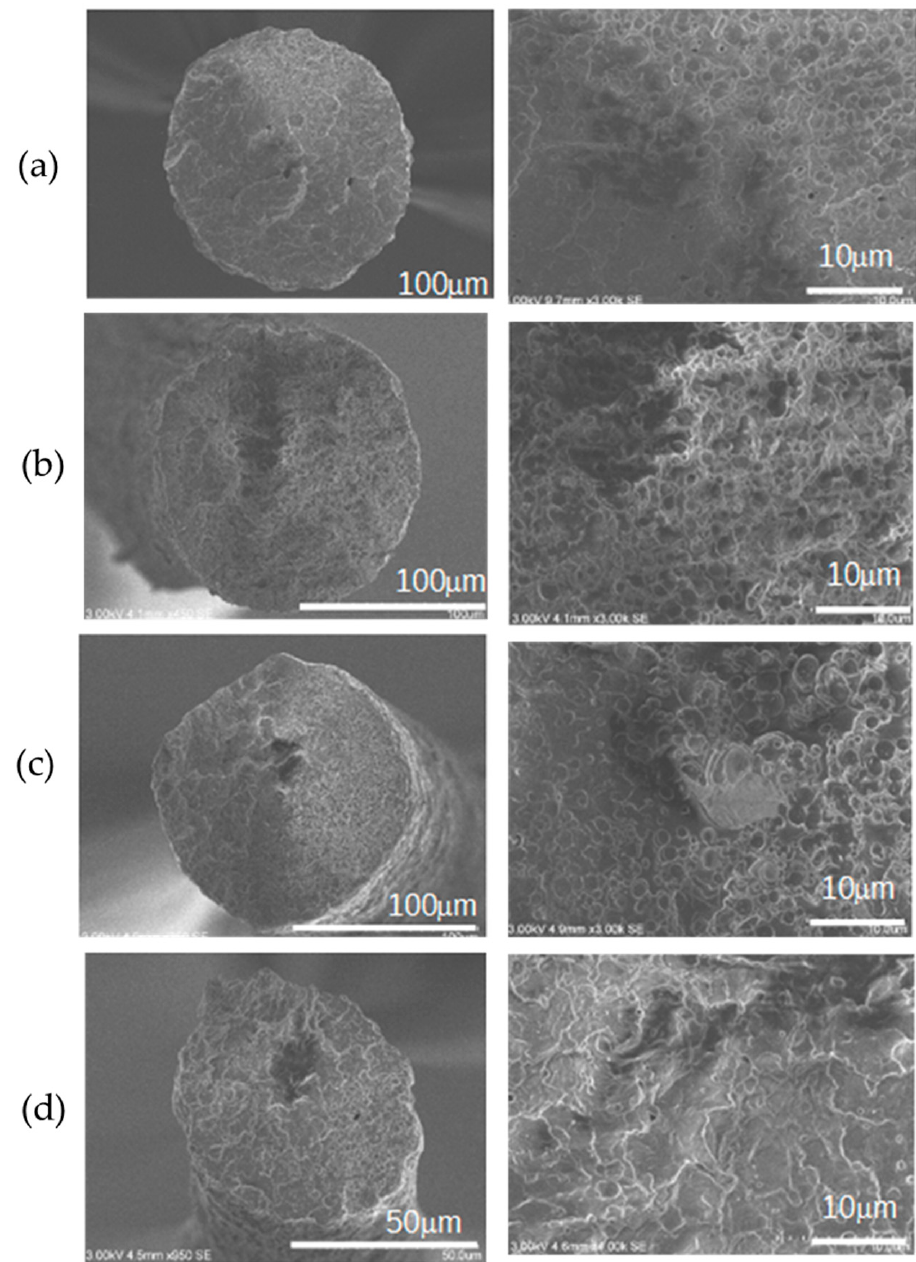
Figure 7. Cross-sectional morphologies of extruded filaments: ( a ) TcC/PA1010, ( b ) TcC/PA1010/TnX_0.5_PC, ( c ) TcC/PA1010/PmD552_0.5_PC and ( d ) TcC/PA1010/PmD1260_0.5_PC.